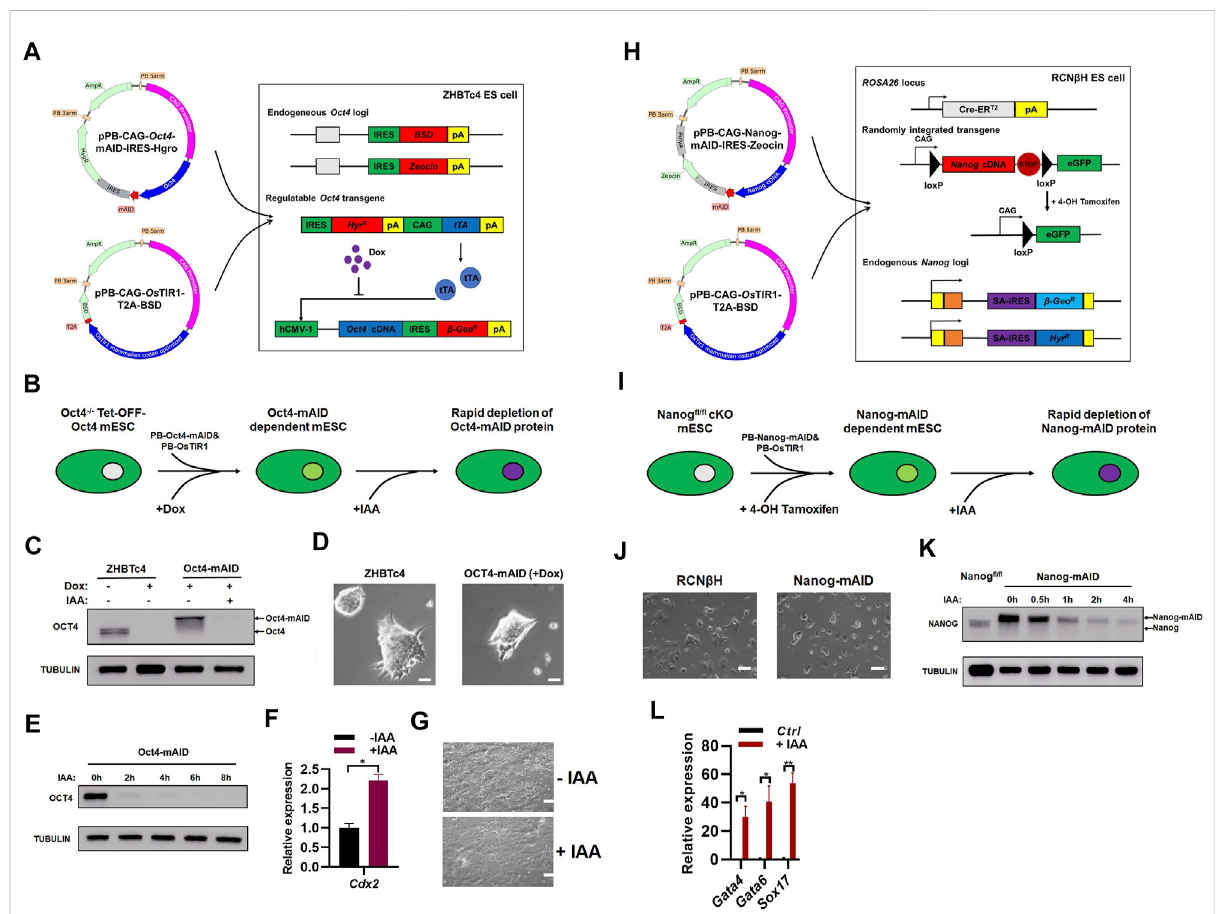
FIGURE 2 Generation of OCT4 and NANOG proteins with a novel AID system. (A) Generation of ZHBTc4:Oct4-AID cell line. The pPB-CAG-Oct4-mAID- IRES-Hygro was produced by fusing mAID to the C-terminus of Oct4 cDNA, separated by a 5-amino acid short linker composed of GGSGG). ZHBTc4 ESCs were transfected with pPB-CAG-Oct4-mAID-IRES-Hygro, pPB-CAG- Os TIR1-T2A-BSD and pPBase vectors, and selected with hygromycin and BSD. During the selection, doxycycline was added to repress the Tet-OFF-Oct4 transgene. (B) Schematic diagram shown the generation ofZHBTc4:Oct4-AID mESCs andauxininduced depletion ofOCT4-AID protein. (C) Immunoblot detection ofOCT4-mAIDand OCT4 in ZHBTc4 and ZHBTc4:Oct4-AID ESCs. Treatment with of IAA for 24 h degraded OCT4-mAID fusion proteins in ZHBTc4:Oct4-AID ESCs. (D) The typical morphology of ZHBTc4 (left) and ZHBTc4:Oct4-AID (right) ESCs. The ZHBTc4:Oct4-AID cells grown in the presence of 1 μ g/ml of doxycycline. Scale - 50 microns. (E) Time course experiment to determine the time required for depletion of the OCT4-mAID protein. The ZHBTc4: Oct4-AID ESCs grown in the presence of 1 μ g/ml of doxycycline were treated with 500 μ M of IAA for the indicated time. The levels of OCT4-mAID protein were analyzed by western blotting using anti-OCT4 antisera. TUBULIN protein was used as a loading control. (F) qPCR analysis of transcript levelsof Cdx2 geneinZHBTc4:Oct4-AIDESCstreatedwith/withoutIAA.Theerrorbarsindicatethreeindependentbiologicalreplicates(mean±SD), * p < 0.05, ** p < 0.001, *** p < 0.0001. (G) The typical morphology of ZHBTc4:Oct4-AID ESCs treated with or without IAA for 3 days. Scale - 100 microns. (H) Generation of RCN β H:Nanog-AID cell line. To generate pPB-CAG-Nanog-mAID-IRES-Zeocin vector, mAID was fused to the C-terminus of mouse Nanog cDNA, separated by a 5-amino acid short linker composed of GGSGG. RCN β H ESCs were transfected with pPB-CAG- Nanog-mAID-IRES-Zeocin, pPB-CAG- Os TIR1-T2A-BSD and pPBase, and selected withZeocin andBSD. During theselection,4-OHT wasaddedto knockout fl oxedNanoginRCN β Hcells. (I) SchematicdiagramshowingthegenerationofRCN β H:Nanog-AIDmESCsandauxininduceddepletionof NANOG-mAID protein. (J) The typical morphology of RCN β H (left) and RCN β H:Nanog-AID (right) ESCs. Scale - 100 microns. (K) Immunoblot detection of NANOG-mAIDand NANOG inRCN β H:Nanog-AIDESCsandNANOG inRCN β H ( Nanog fl / fl )ESCs. Treatment with 500 μ Mof IAAfor the indicated time degraded NANOG-mAID fusion proteins in RCN β H:Nanog-AID ESCs. The levels of NANOG-mAID protein were analyzed by western blotting using anti-NANOG antisera. TUBULIN protein was used as a loading control. (L) qPCR analysis of transcript levels of Gata4 , Gata6 and Sox17 genes in 3 days ’ embryoid bodies induced from RCN β H:Nanog-AID ESCs treated with/without IAA. The error bars indicate three independent biological replicates (mean ± SD), * p < 0.05, ** p < 0.001, *** p <